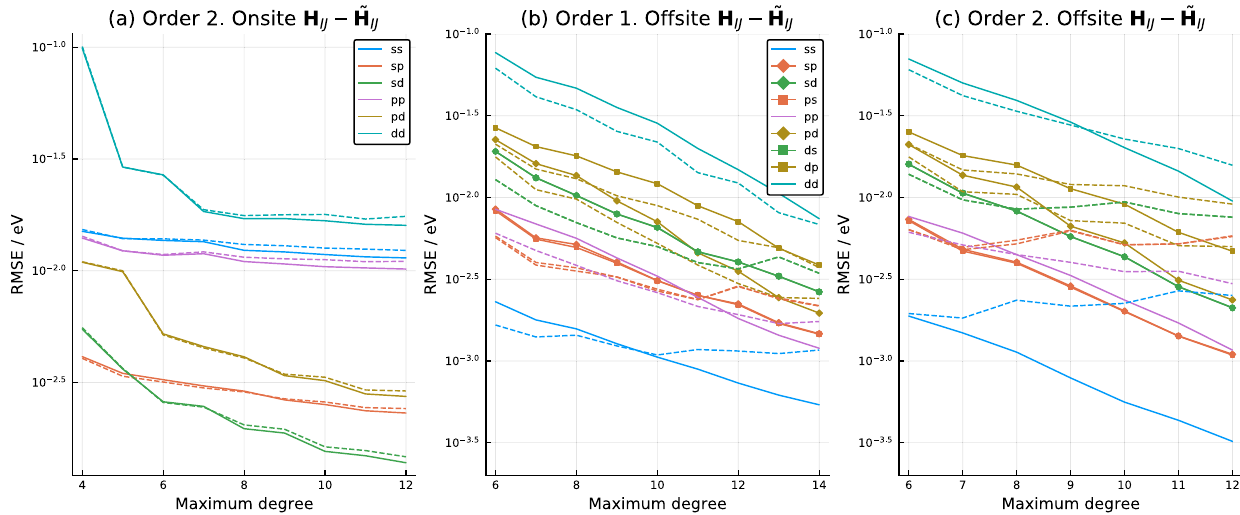
Fig. 3 Convergence of Hamiltonian and overlap blocks with respect to the order and maximum degree of the ACE basis set. a Onsite Hamiltonian blocks H II fi tted with order 2 models of varying maximum degree. b Offsite Hamiltonian blocks with order 1 ACE models. c Offsite Hamiltonian blocks with order 2 ACE models. In all plots solid lines show errors on training data and dashed lines errors on test data. Colours match the block structure of Fig. 2. Note the distinct markers that distinguish the non-adjoint entries in the offsite Hamiltonian and overlap